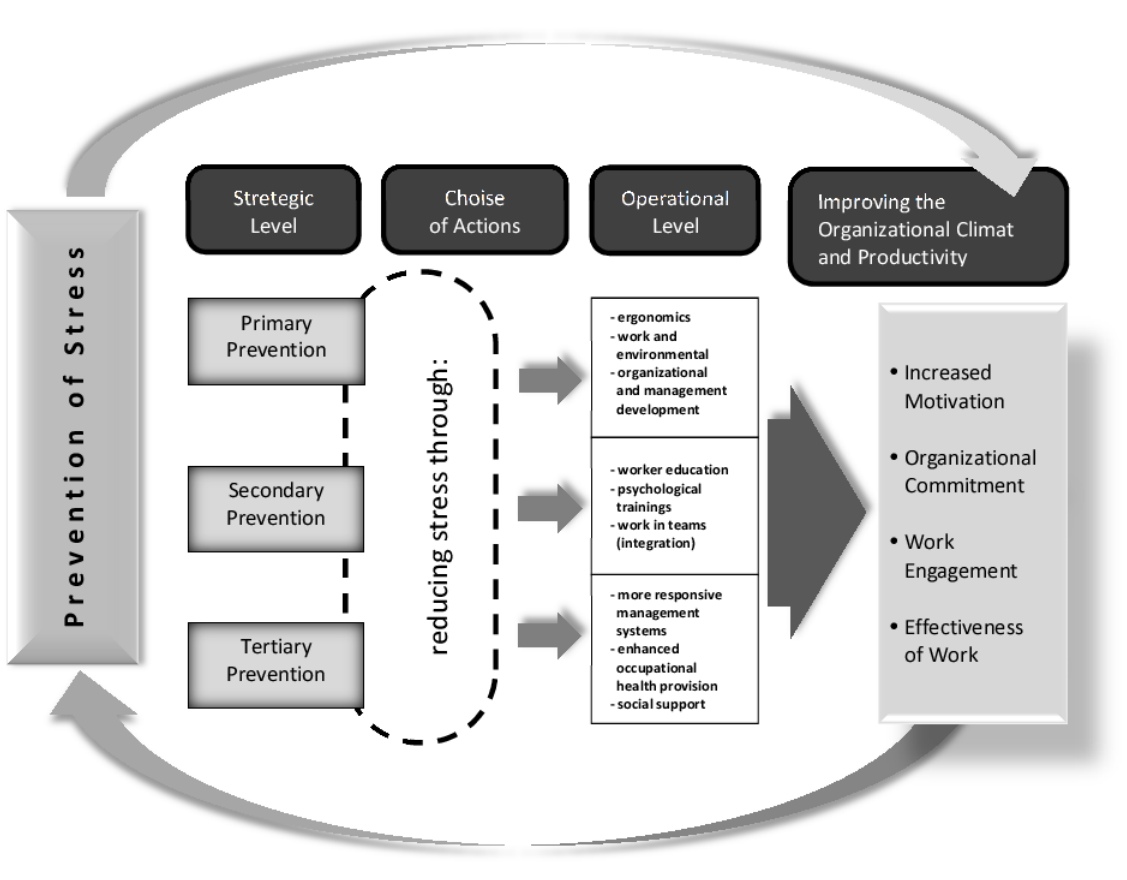
Figure 2. The prevention model of stress – a universal approach (own